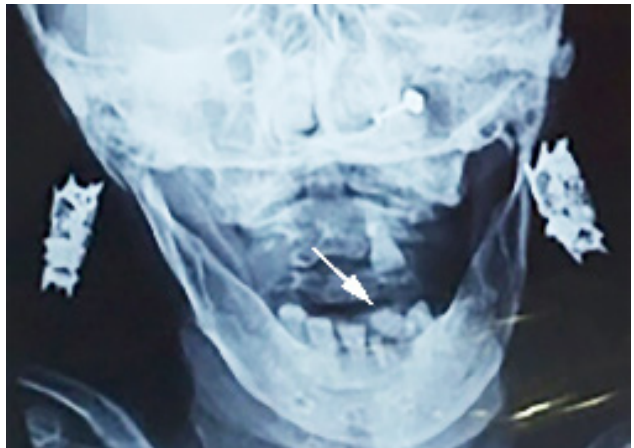
Fig 1 : X-ray mandible (PA view) showing radioopacity at left lower canaine region